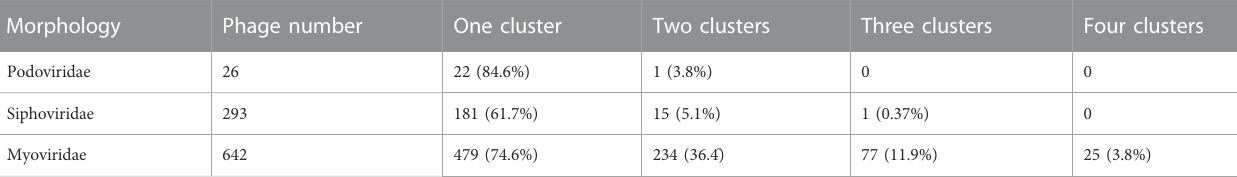
(Table 1). By analyzing the occurrence and frequency of keywords